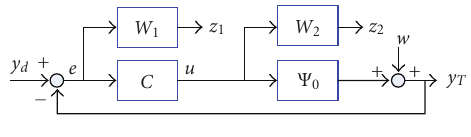
Figure 1: Block diagram of the